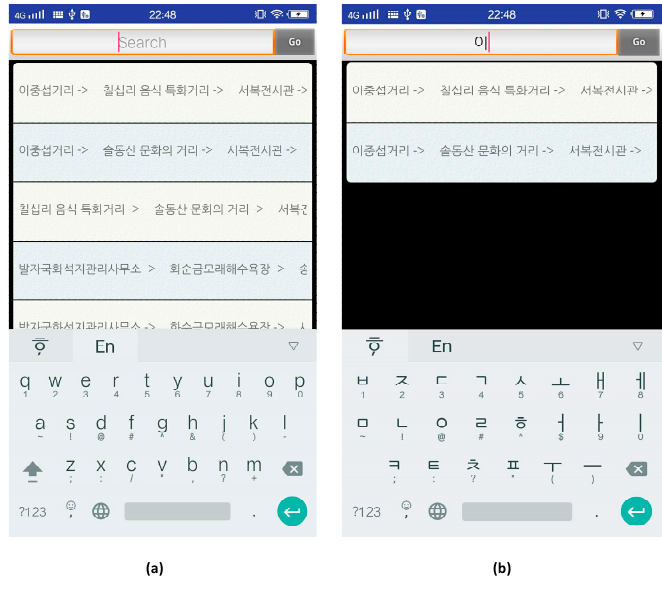
Figure 14. ( a ) travel route list form; ( b ) search route using keywords.